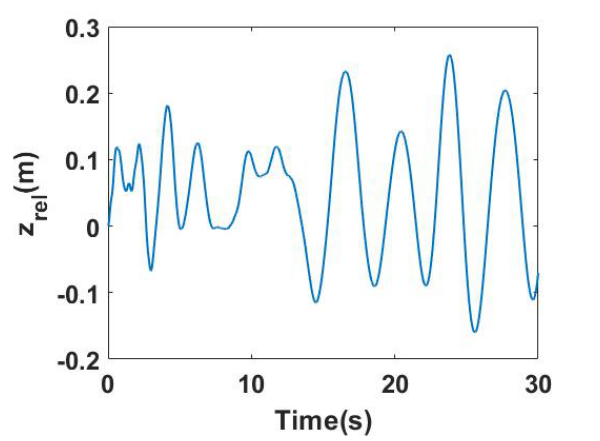
Figure 23. Difference in motions of FSB WEC and VSB WEC in heave